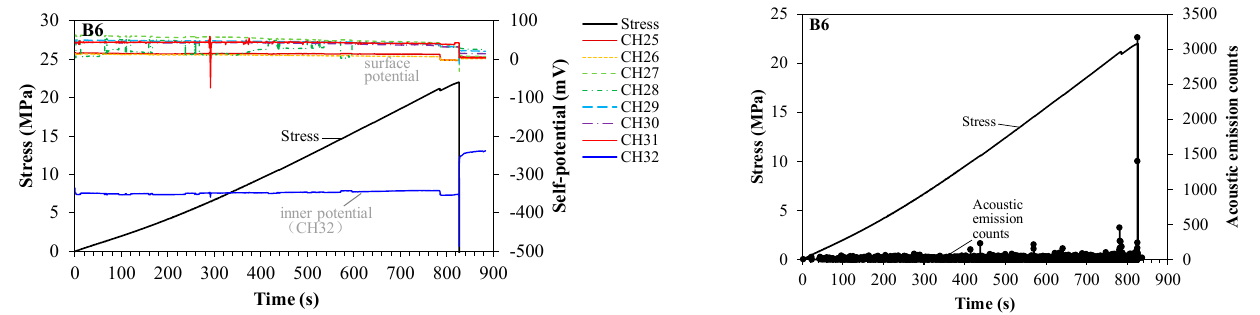
Figure 4. Response characteristics of bituminous coal self-potential and acoustic emission counts with time during uniaxial fracturing. Samples A1 to A6 were obtained parallel to the bedding and samples B1 to B6 were drilled perpendicular to the bedding.